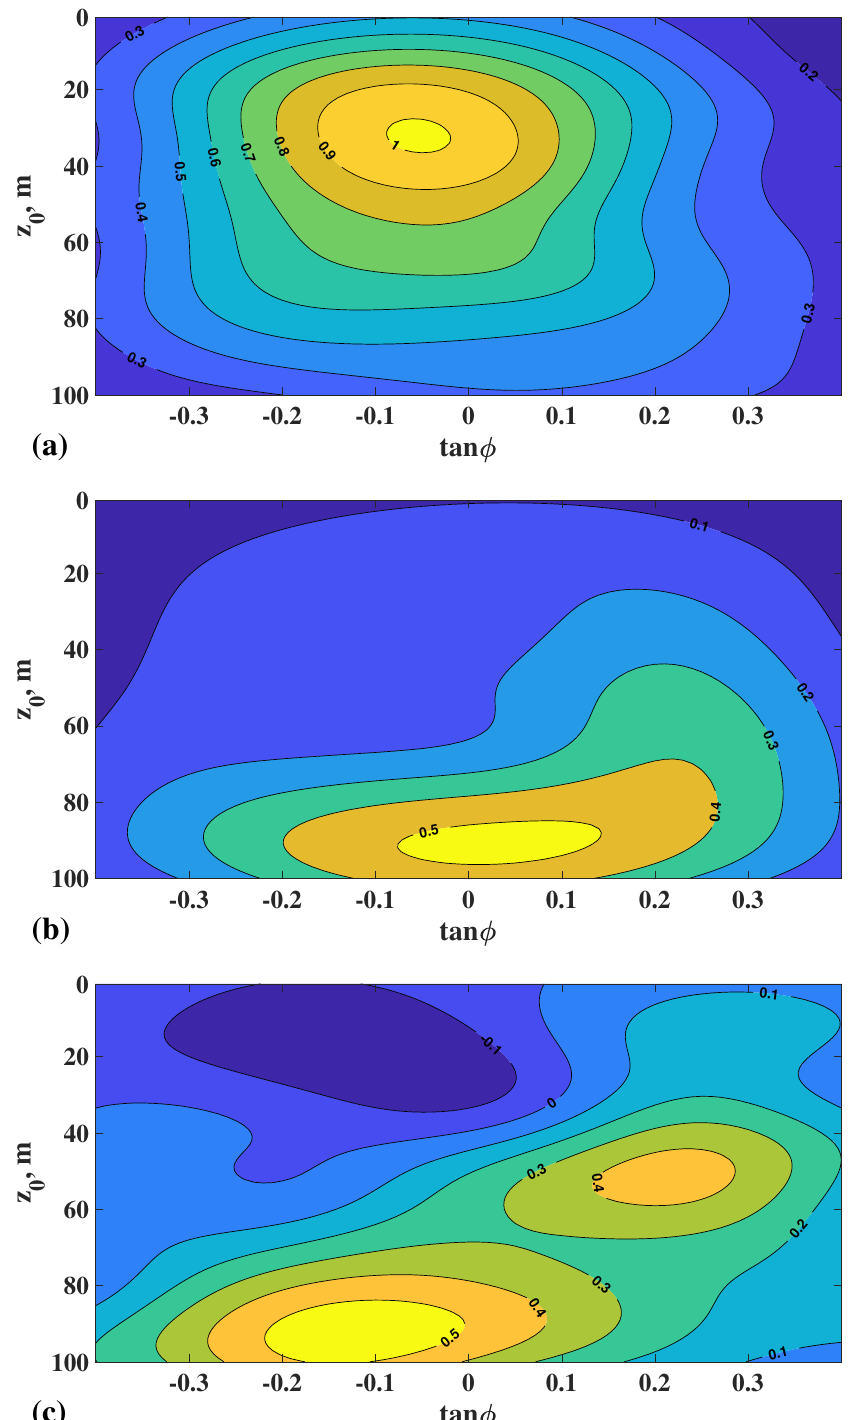
Figure 6. Scanning of the waveguide crossing the pockmark between r 1 = 8000 m and r 2 = 8300 m. Panel ( a ) shows dependence of the transmission coefficient on tangent of the launching angle and √ the initial depth z 0 of a directed Gaussian wave beam, the noise amplitude σ = 0.05. Panels ( b , c ) illustrate the difference δ T in the same coordinates as in the panel ( a ). The panel ( b ) corresponds to data obtained with the propagator without impact of noise, and the panel ( c ) shows data averaged √ over 100 realizations of ambient noise with the amplitude σ =